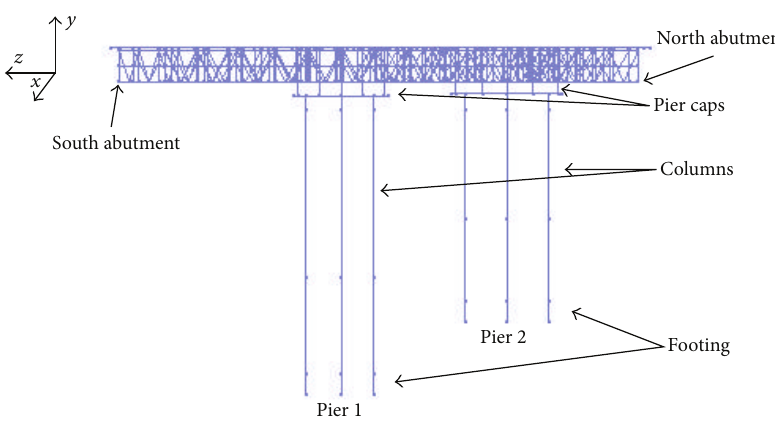
Figure 5: 3D bridge